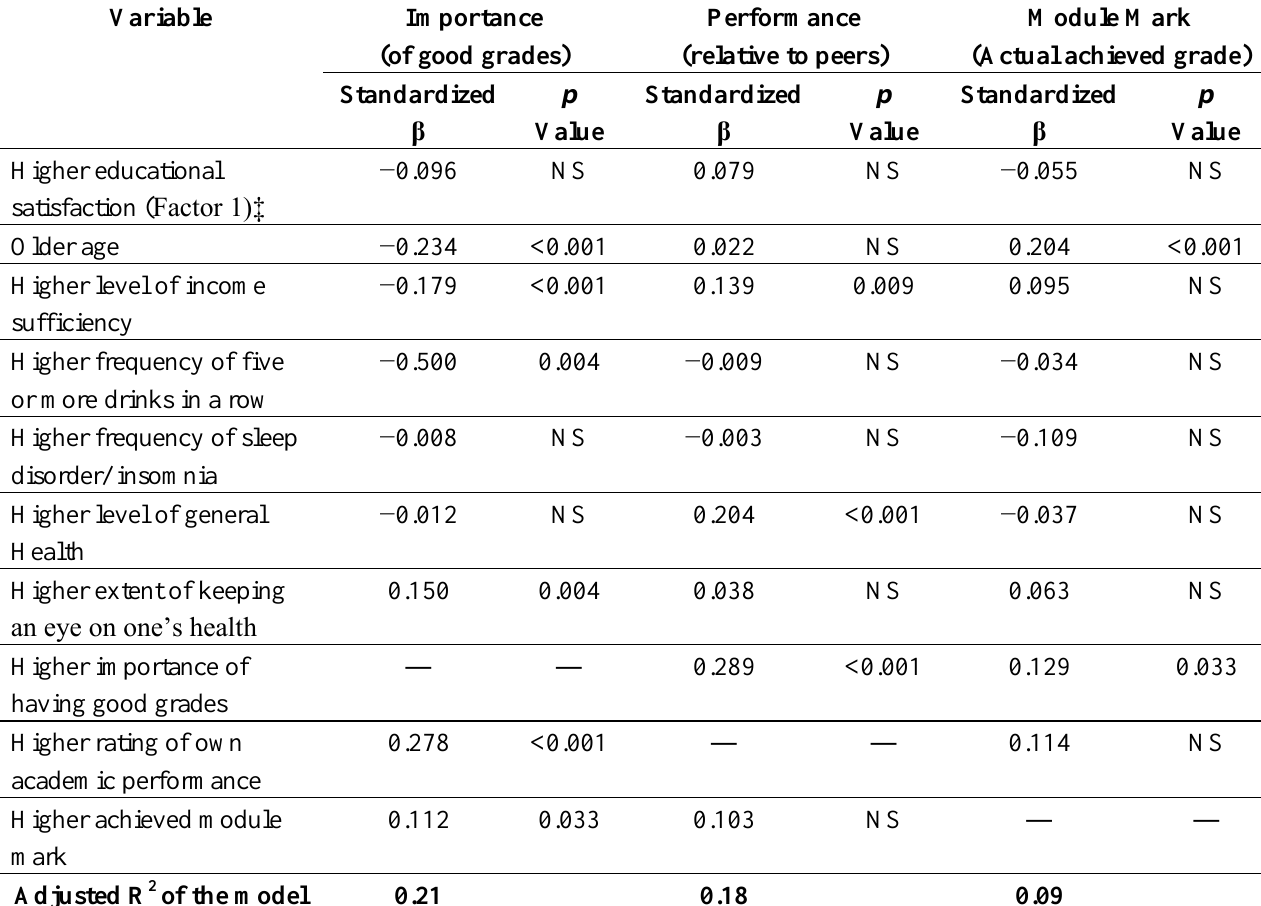
Table 2. Regression Models For Three Different Indicators of Educational Achievement †